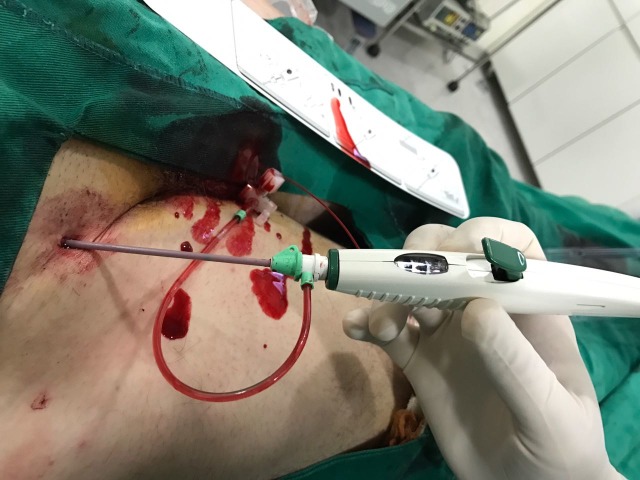
Insertion of device in the introducer.